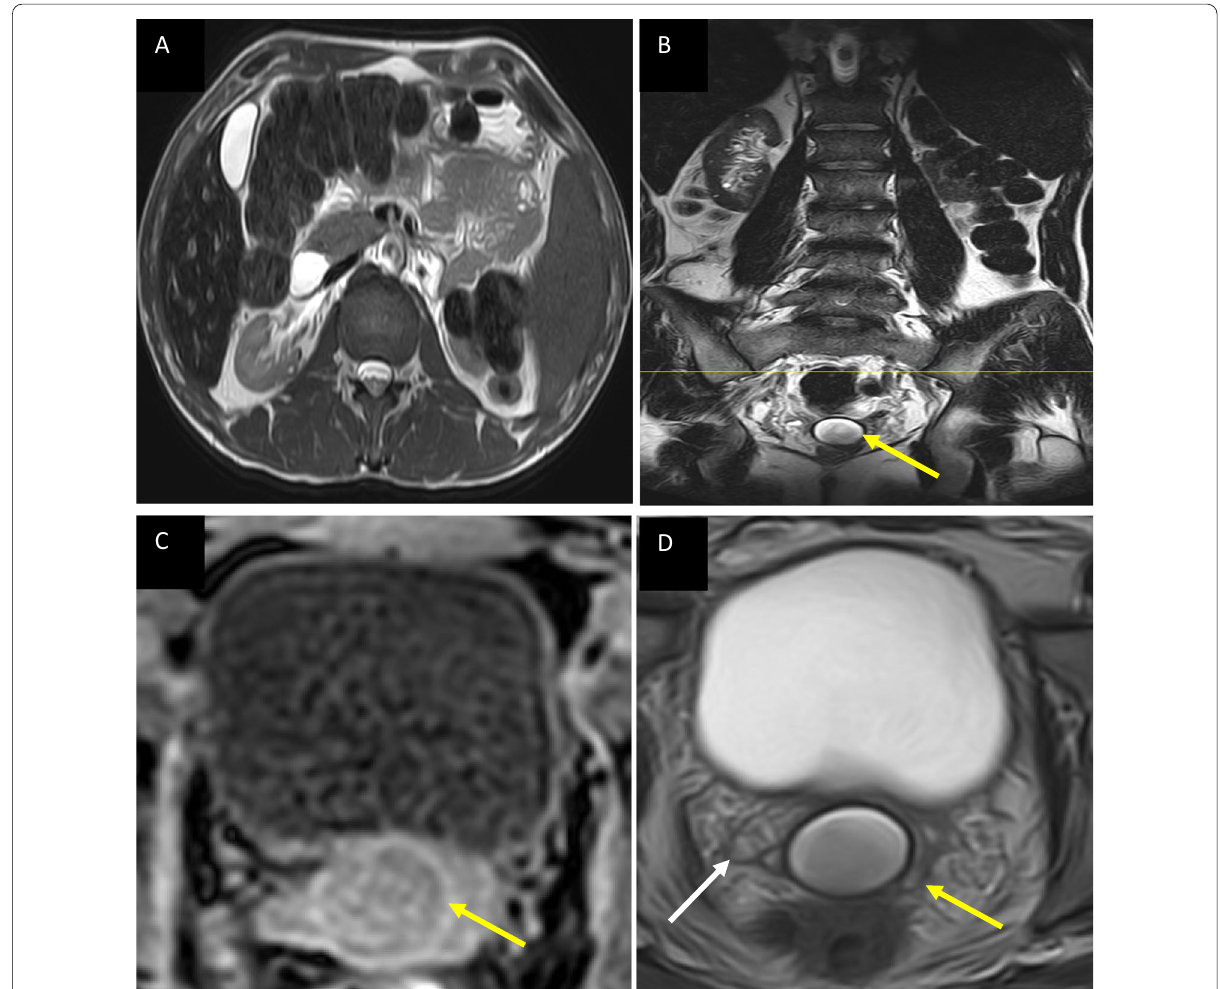
Fig. 5 A Axial T2WI of the abdomen and B coronal T2WI of the abdomen and pelvis show Small sized right kidney with pyelonephritic changes (in the form of reduced parenchymal thickness, increased thickness of sinus fat, irregular contour) and left renal agenesis, ( C – F ) high‑resolution axial fat‑suppressed T1WI and axial, coronal and right parasagittal T2WI of the pelvis revealed normal right SV (white arrow) and left SV cyst (yellow arrow) measured (2.5 2.3 cm). It displays high T2WSI and intermediate to low T1WSI denoting clear fluid ×